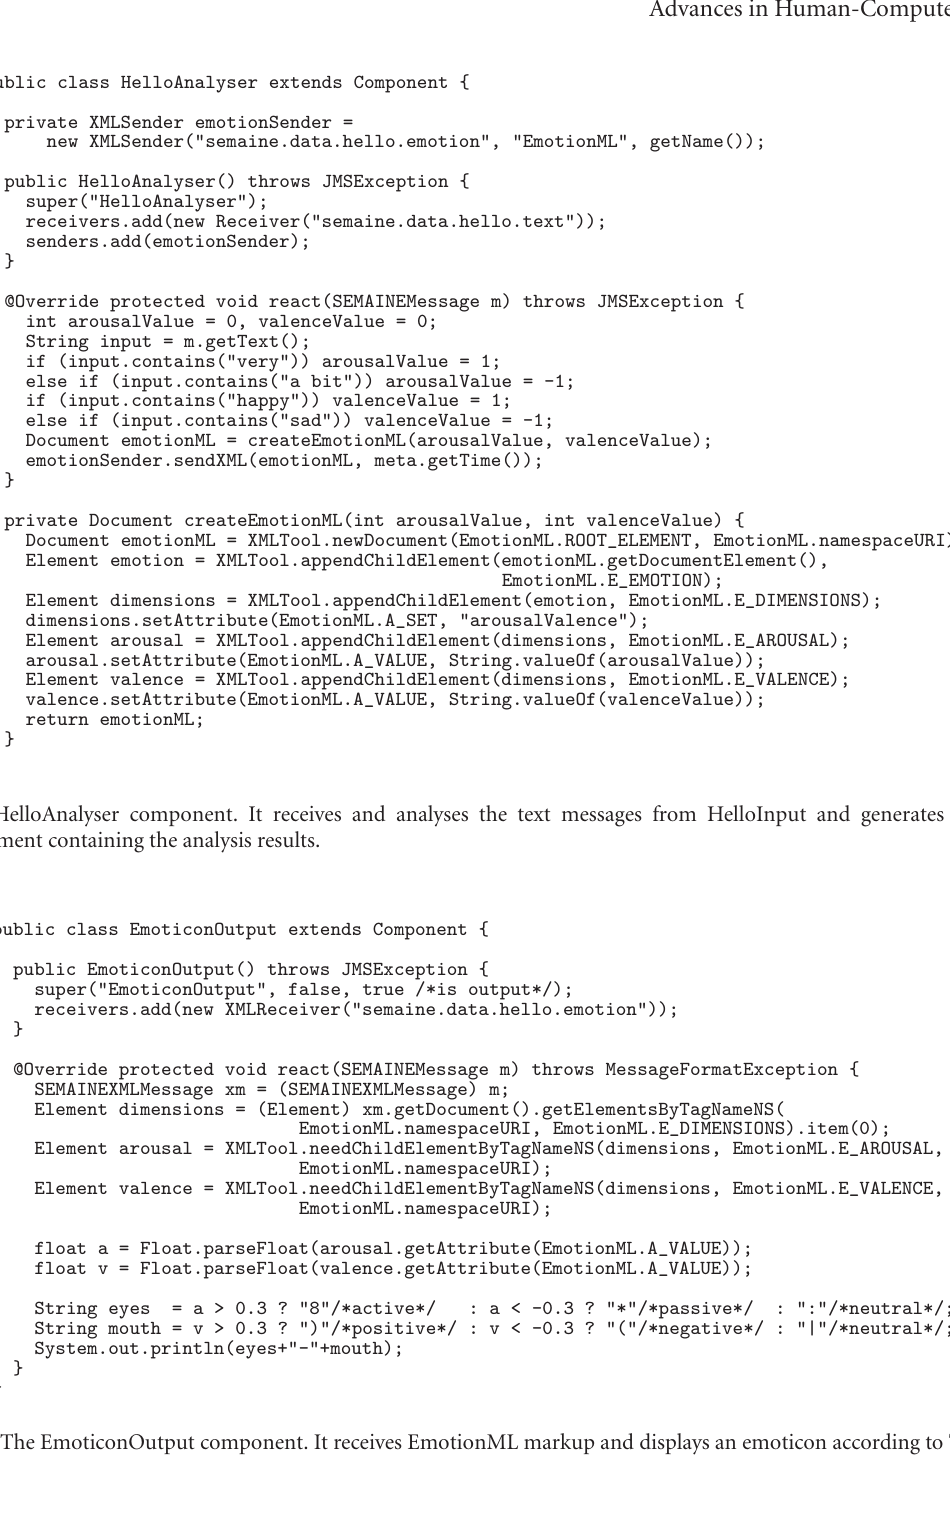
semaine.components = \ |eu.semaine.components.meta.SystemManager| \ |eu.semaine.examples.hello.HelloInput| \ |eu.semaine.examples.hello.HelloAnalyser| \ |eu.semaine.examples.hello.EmoticonOutput| semaine.systemmanager.gui = true Figure 15: The configuration file example-hello.config defining the Hello